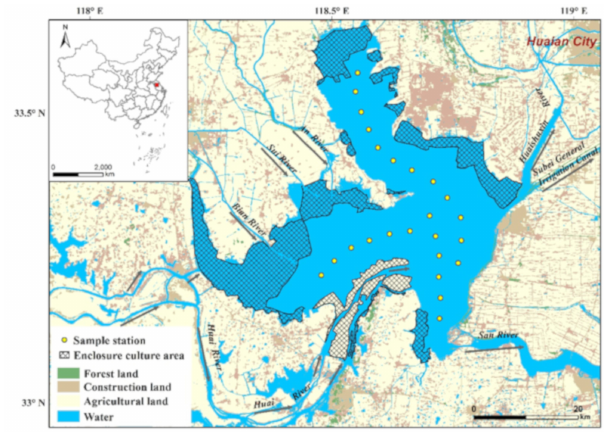
Figure 1. Location of the study site and sampling